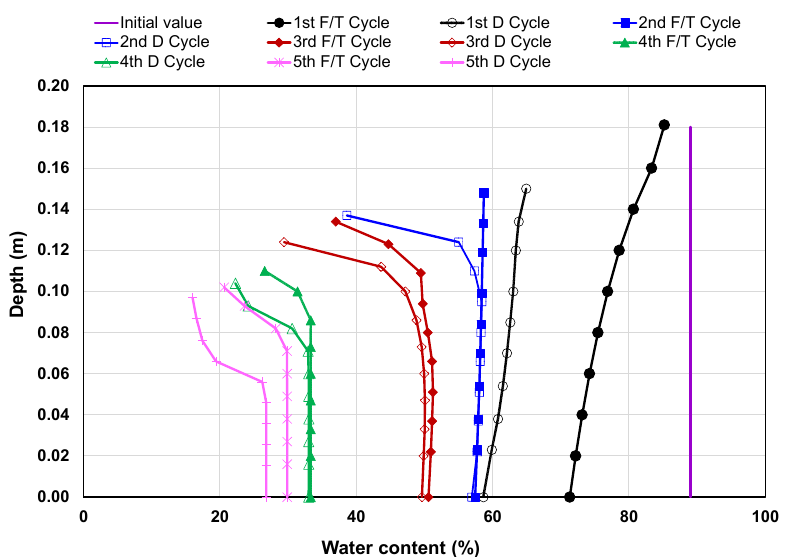
Figure 7. Water content profile simulation of centrifuged tailings at a temperature gradient of 0.083 °C/mm.